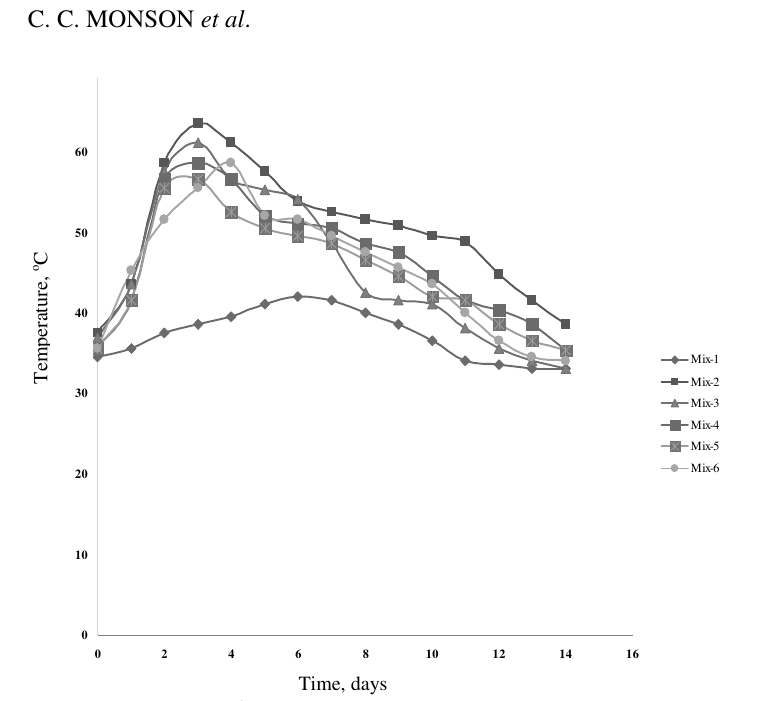
Figure 1. Variation of substrate